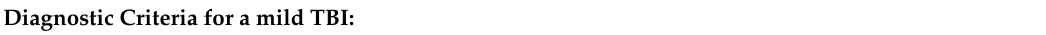
Table 1. Diagnostic criteria for a mild traumatic brain injury (Mild Traumatic Brain Injury Committee, Head Injury Interdisciplinary Special Interest Group, American Congress of Rehabilitation Medicine)